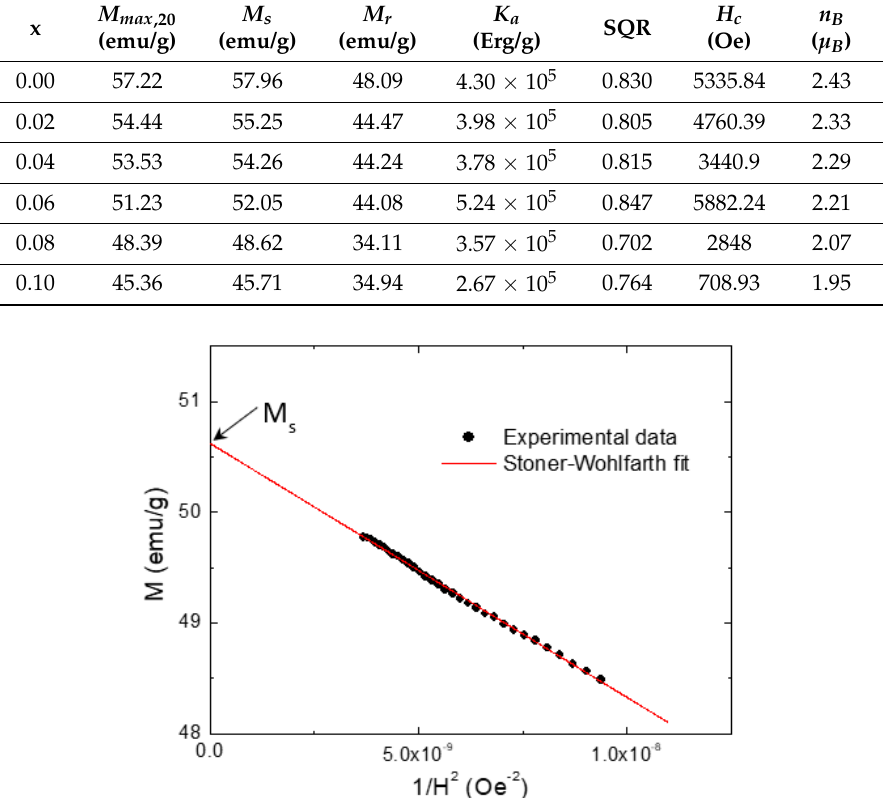
Figure 9. A schematic example of the M vs. 1/H 2 plot for the Co 0.5 Ni 0.5 Fe 2 O 4 nanoparticles at RT.